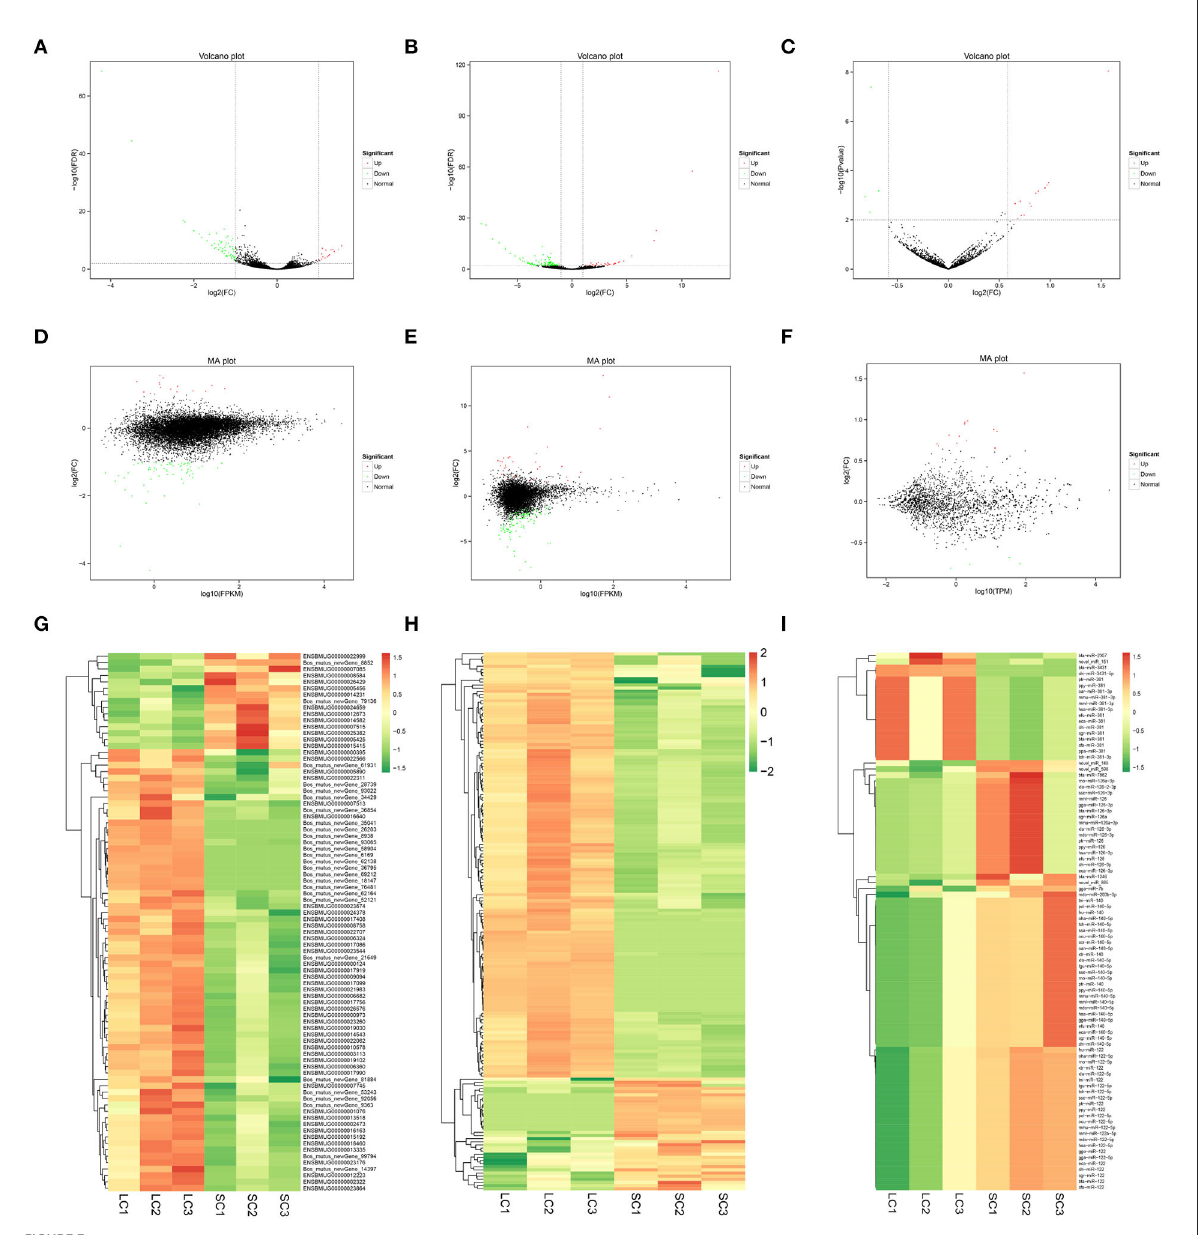
FIGURE3 Volcano map, MA plot, and hierarchical clustering heat maps of DEmRNAs, DElncRNAs, and DEmiRNAs. (A) Volcano map of DEmRNAs. (B) Volcano map of DElncRNAs. (C) Volcano map of DEmiRNAs. (D) MA plot of DEmRNAs. (E) MA plot of DElncRNAs. (F) MA plot of DEmiRNAs. (G) Heat maps of DEmRNAs. (H) Heat maps of DElncRNAs. (I) Heat maps of DEmiRNAs.